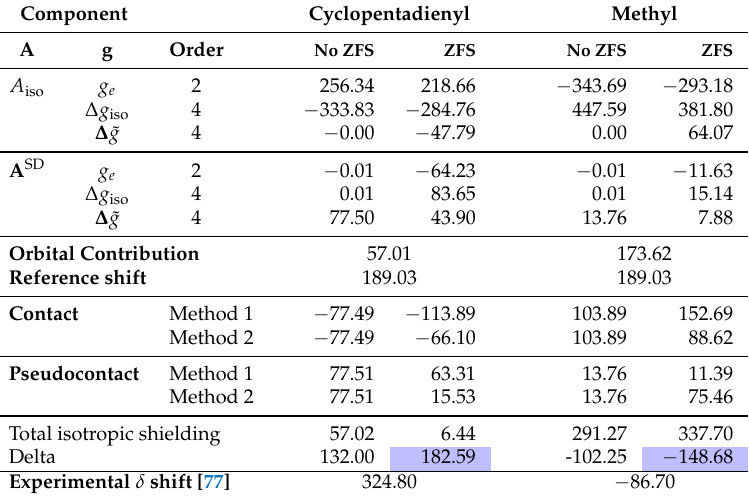
Table 9. Calculated 13 C pNMR shifts for U(C 5 Me 5 ) 3 in ppm with no spin-orbit corrections to the hyperfine term at 298 K). The final, ZFS corrected, computational values are